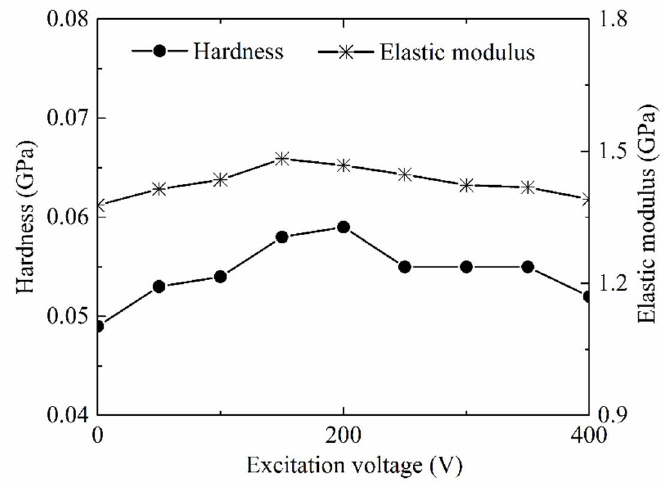
Figure 7. Effects of excitation voltage on the hardness and modulus of the PP parts.